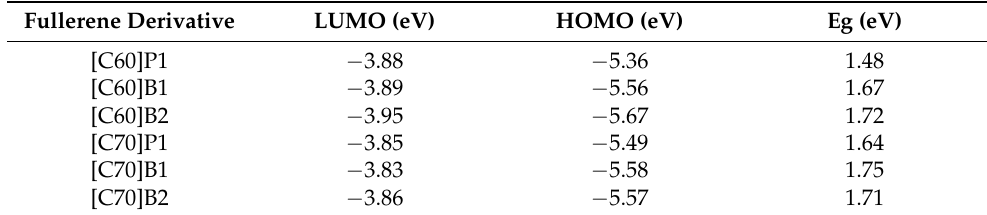
Table 1. HOMO and LUMO levels and LUMO-HOMO energy gaps (Eg) determined from the CV